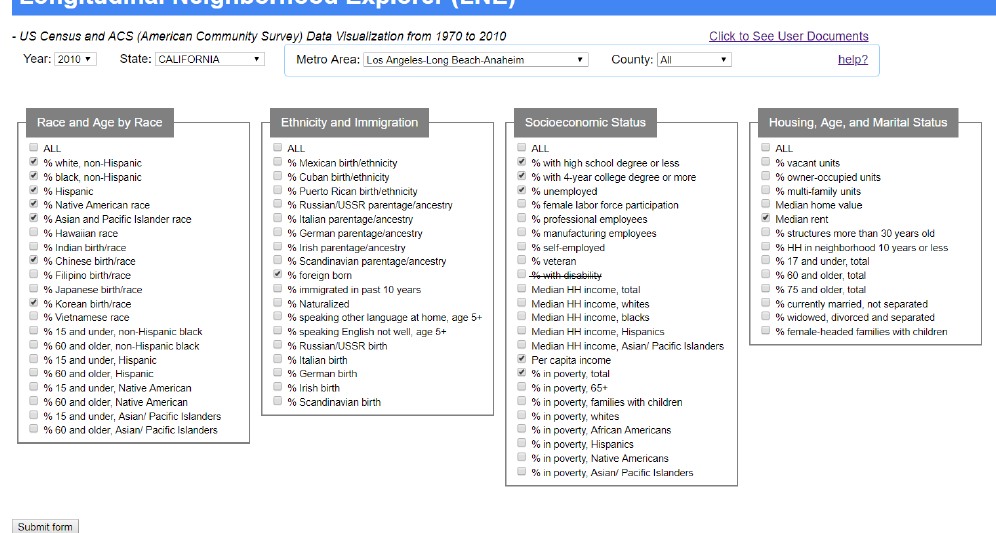
Figure 3. The first part of the user interface of Longitudinal Neighborhood Explorer (LNE). It was designed to get inputs from users. The LNE is available at http://sarasen.asuscomm.com/LNE/intro.html.